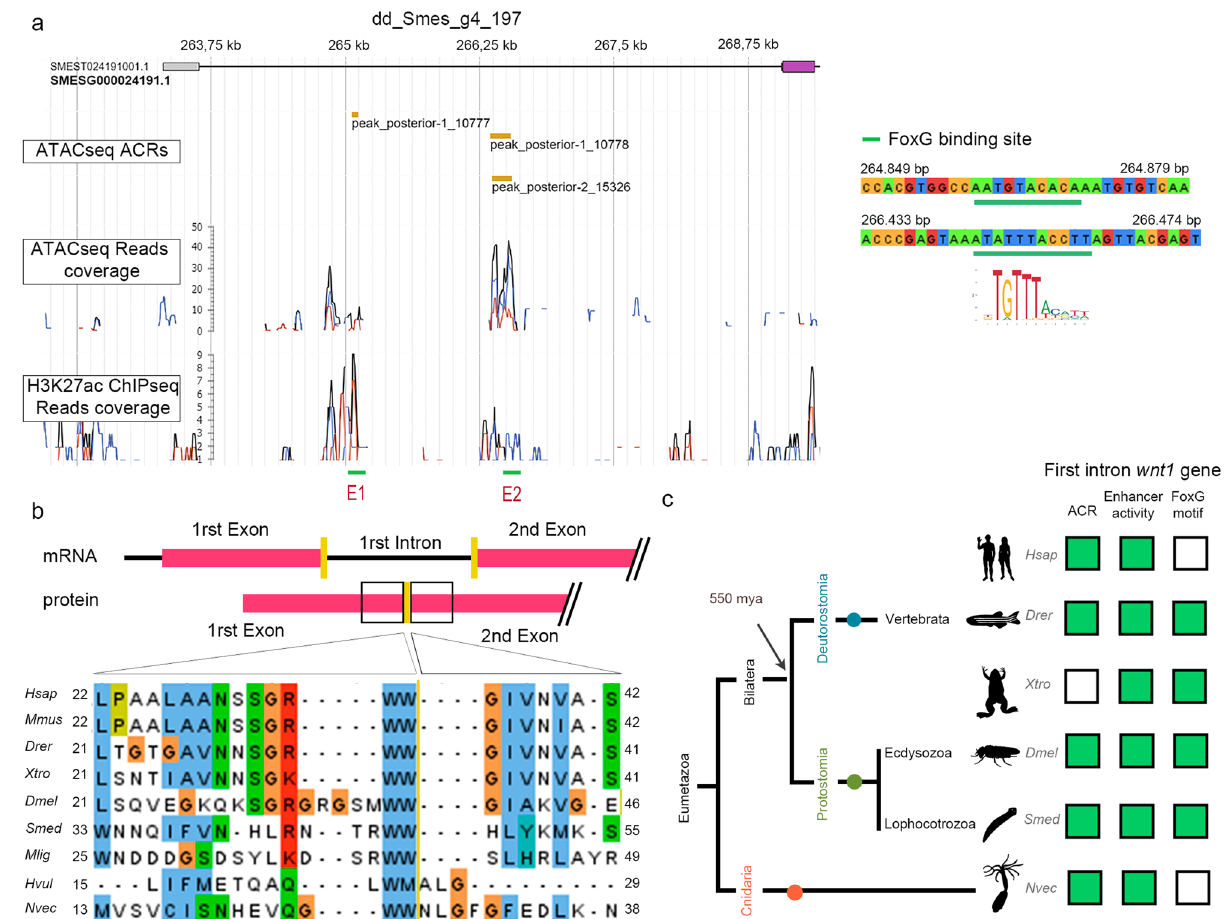
Fig. 3 | FoxG could bind to a cis-regulatory element found in wnt1 fi rst intron. a Schematic illustration of Smed-wnt1 gene locus, indicating exons (violet boxes) linked by introns (lines). Genome Browser screenshot showing the ATAC-seq Accessible ChromatinRegions (ACRs),ATAC-seq and H3K27acChIP-seq pro fi les of theputativeenhancerregions.PutativeEnhancer1(E1)andEnhancer2(E2)present a FoxG motif (SLP1) (green line). The ATAC-seq peaks corresponding to E1 and the E2 are indicated. b Alignment of WNT1 amino acid sequences show the conserva- tionoftheintron1position.Yellowlineshowstheseparationbetweenthe fi rstand the second exon. c Schematic summary of accessible chromatin regions (ACRs), enhancer activity and FoxG motif evidence in the fi rst intron of wnt1 genes in